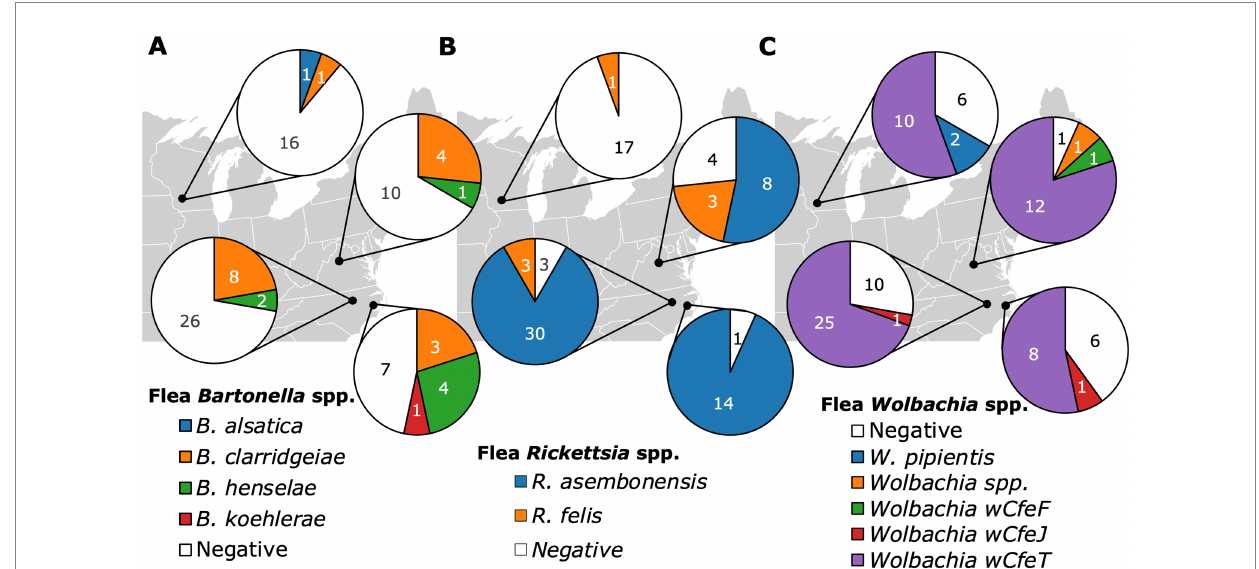
FIGURE 5 Pie charts displaying the Bartonella (A) , Rickettsia (B) , and Wolbachia (C) infection status of fleas based on their geographic location of origin including Raleigh NC, Washington NC, Orange VA, and Madison